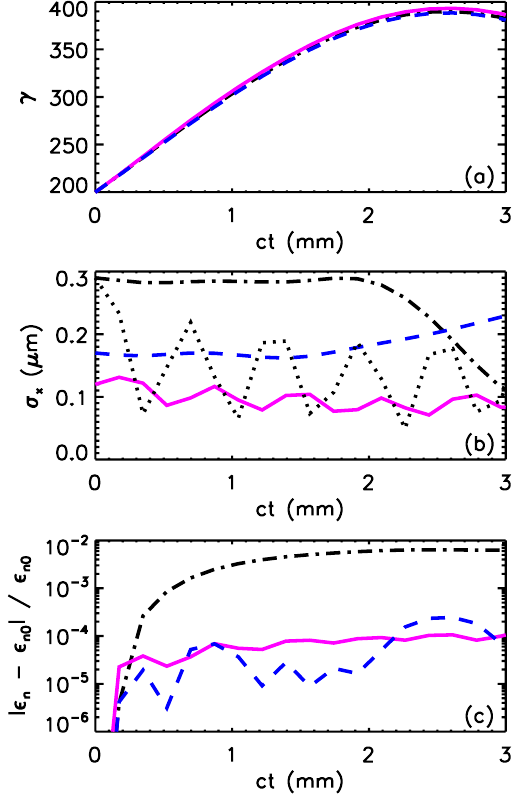
¼ 0 : 42 , after (cid:4) p 0 s FIG. 8. Results of 2D PIC simulations of a test electron beam propagating in a wakefield driven by a Gaussian mode only [thick solid line (magenta)], a Gaussian plus a Hermite-Gaussian mode [dashed line (blue)], and a Gaussian plus a Hermite- ¼ 0 : 2 [dash-dotted (black)]. (cid:4) Gaussian mode, delayed by k p 0 s (a) Energy gain, (b) evolution of the radius of the electron beam as a function of propagation distance, the dotted line shows the evolution of an unmatched beam in a wakefield driven by a Gaussian pulse, and (c) evolution of the beam emittance, (cid:3) (cid:8) j =(cid:8) ¼ 0 : 014 mm mrad j (cid:8) , with (cid:8) n n 0 n 0 n 0